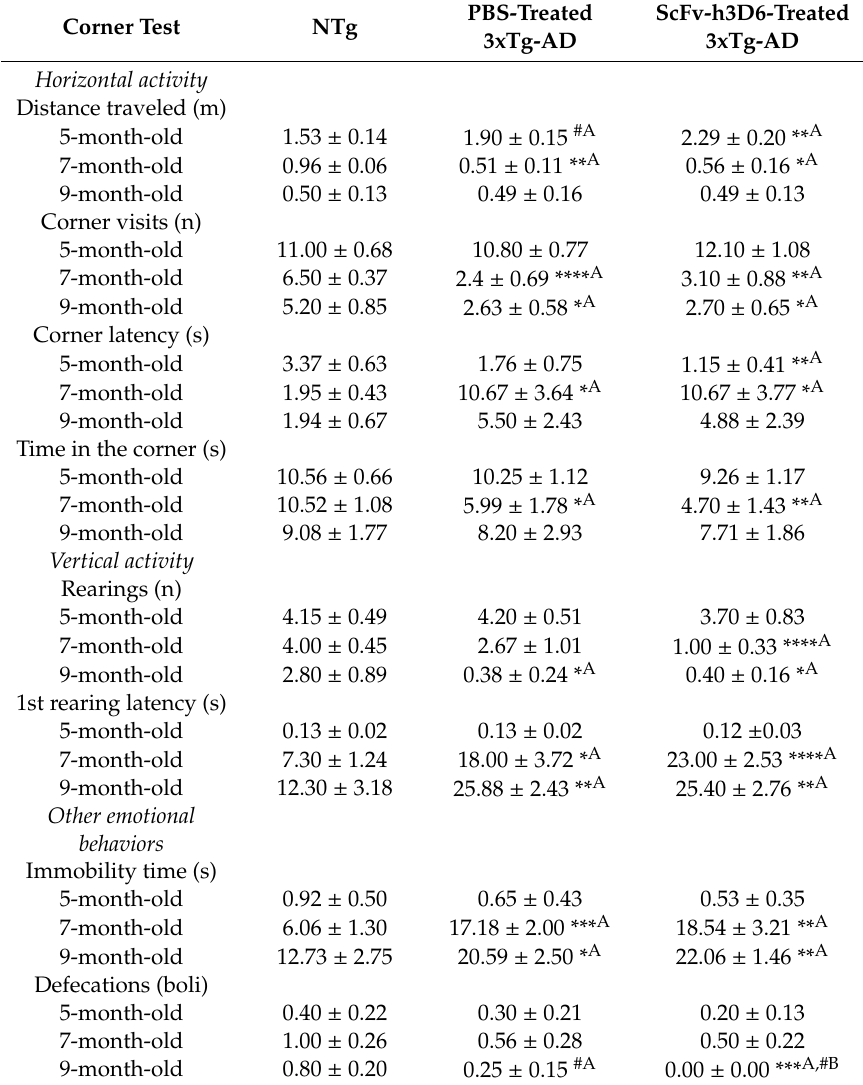
Table 1. Corner test data. Values are expressed by means and SD. # indicates a low, but not significant, p -value 0.05 < p ≤ 0.1, * significant di ff erences with p ≤ 0.05, ** p ≤ 0.01, *** p ≤ 0.001, and **** p ≤ 0.0001. A refers to NTg / - mice and B refers to 3xTg / - mice.